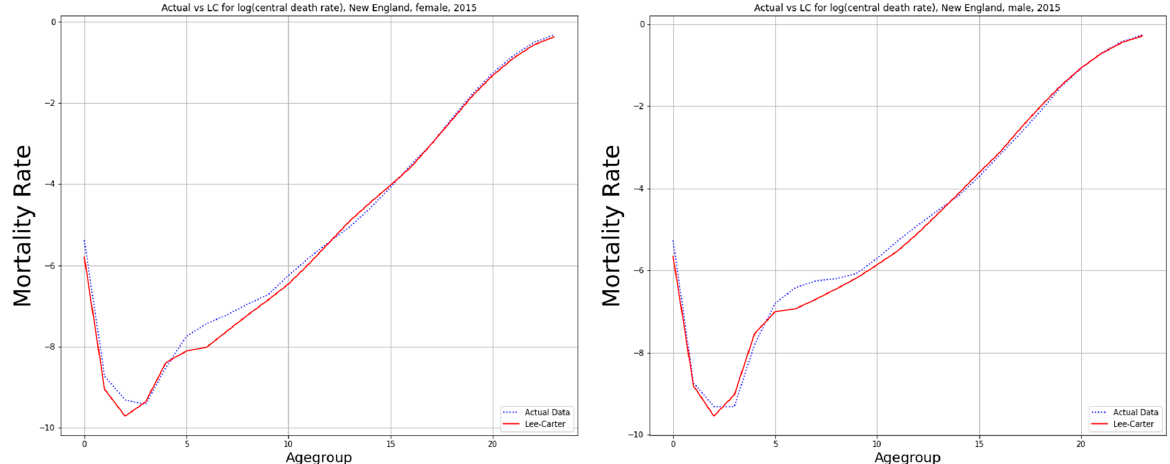
Figure 9. The predictions of the log-mortality rate for New England female ( left ) and male ( right ), 2015.